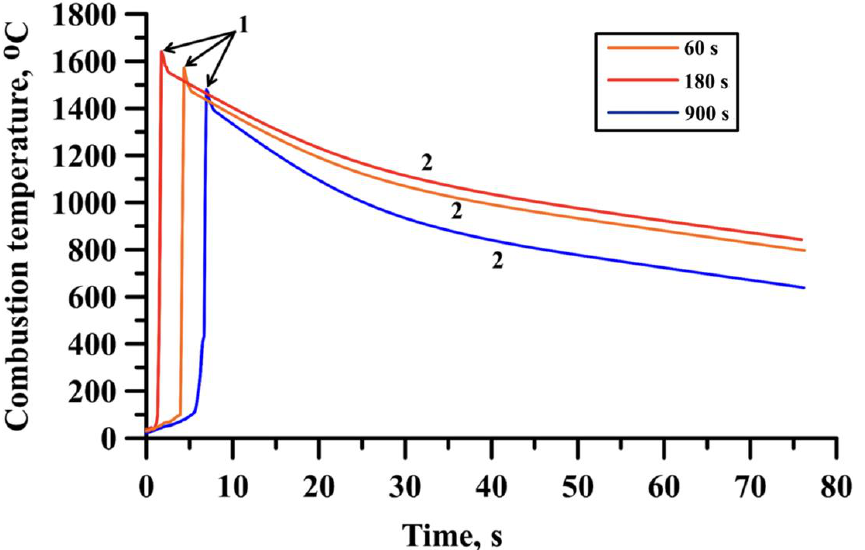
Figure 3. Typical heat patterns of the samples obtained from Al-Ti-B powder mixture after 60, 180, and 900 s of mechanical activation. and 900 s of mechanical